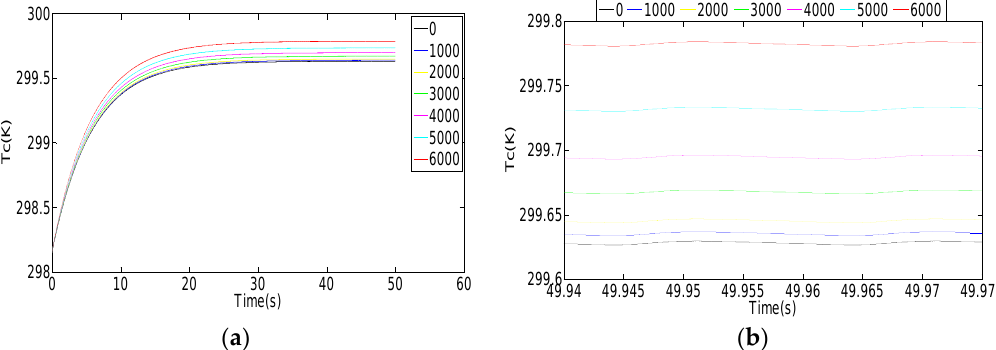
Figure 8. ( a ) The transient case temperature under different cycle times, ( b ) The steady state case temperature under different cycle times.